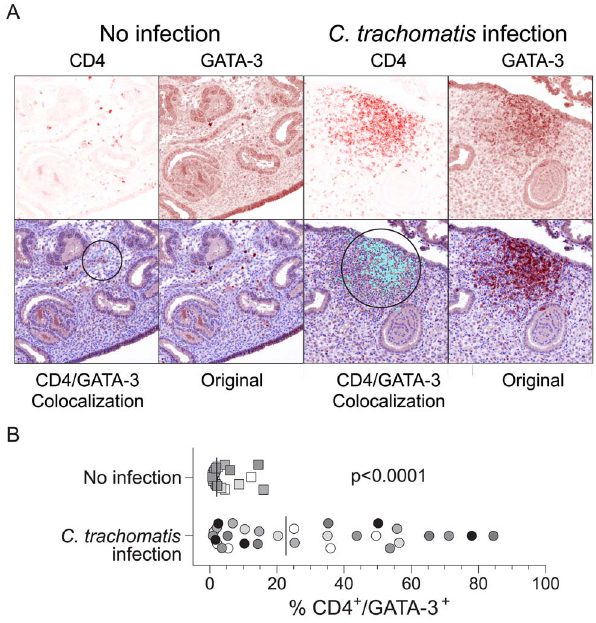
Figure 5. Endometrial Chlamydia infection causes infiltration of CD4 + T cells expressing GATA-3. Sections of paraffin-embedded endometria from women with no identified C. trachomatis , N. gonorrhoeae , or T. vaginalis lower or upper genital tract infection (n=4) or with endometrial C. trachomatis infection (n=6) were utilized to simultaneously detect the expression of GATA-3 (DAB) and CD4 (Vector Red) using immunohistochemistry, as described in Methods section. (A) In uninfected endometrial tissue, we observed scarce numbers of CD4 + cells coexpressing GATA-3, however, in endometrial tissue from Chlamydia -infected women the presence of aggregates of GATA-3 + CD4 + mononuclear cells was patent (representative micro- graphs shown at X200 magnification). Upper left panels show images displaying Vector Red staining, while upper right panels show images displaying DAB staining as defined by spectral analysis. Lower right panels show original images used in analysis, and lower left panels show images in which GATA-3 and CD4 colocalization areas have been digitally highlighted (light blue). Circles delineate areas of highest colocalization in images shown. (B) Colocalization of CD4 + areas within GATA-3 + areas increases dramatically with Chlamydia infection, indicating that endometrial Chlamydia infection drives the infiltration of GATA-3 + CD4 + T cells that form aggregates. Each symbol represents the percentage of colocalization observed in a single field. Matching colors indicate all the fields evaluated from one specimen. Comparison was performed using a two-tailed Mann-Whitney test (horizontal bars indicate medians).